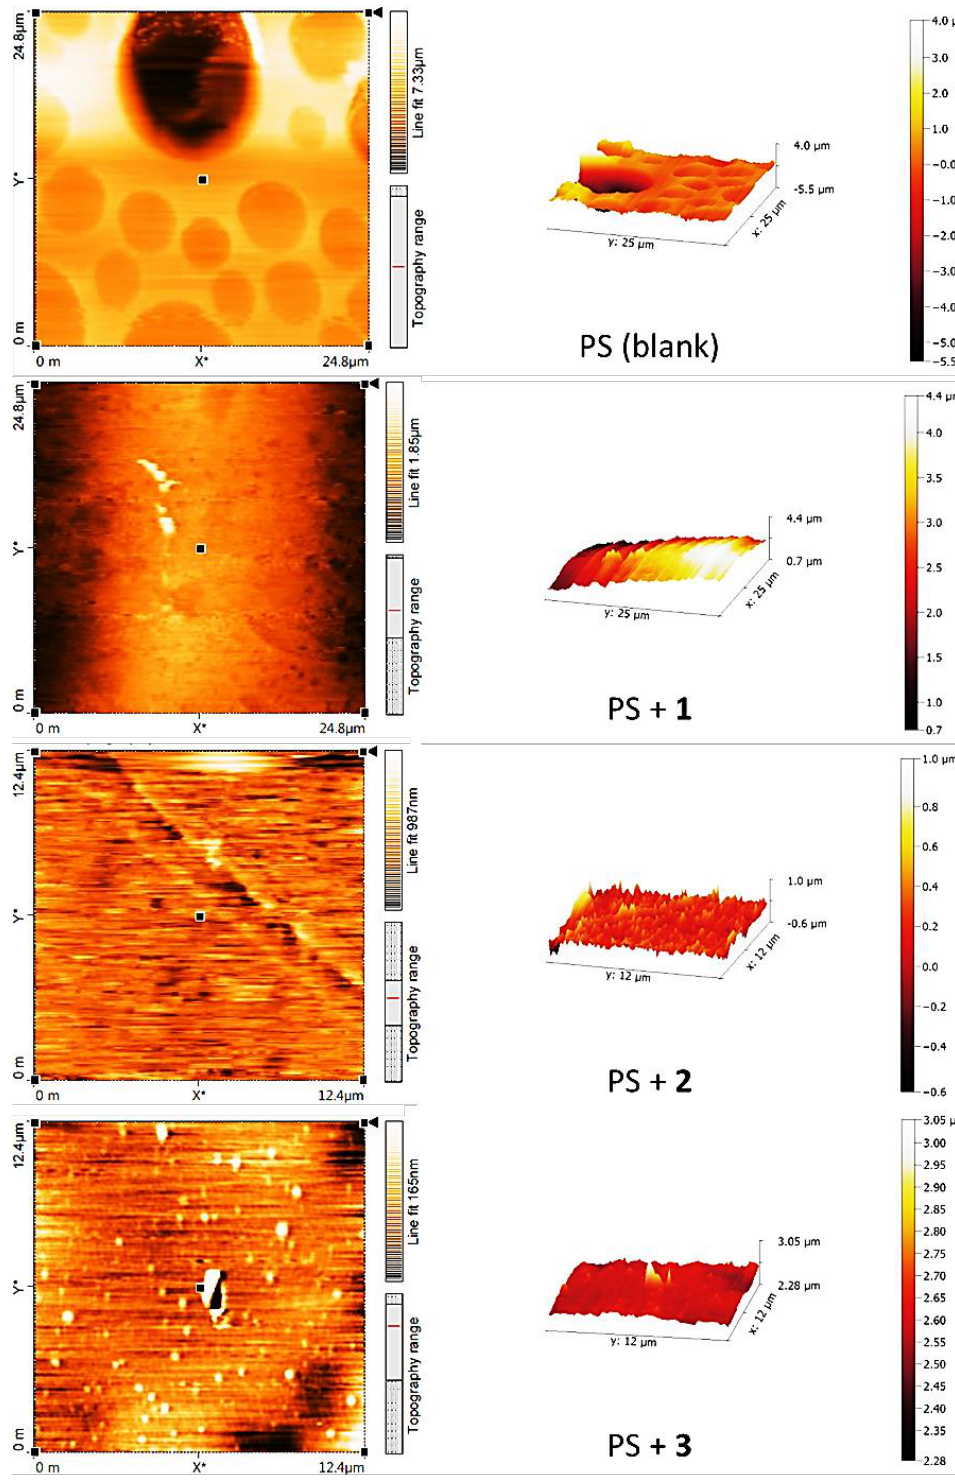
Figure 14. 2D and 3D AFM images of PS and PS/Schiff bases 1 – 3 blends after irradiation.